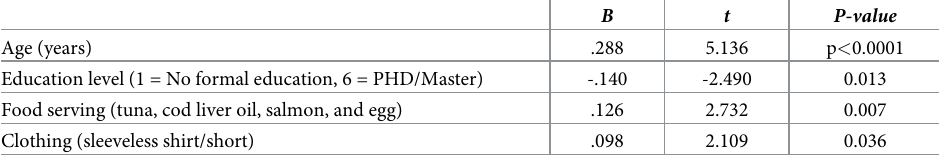
Bone pain as a symptom of hypovitaminosis was noted more frequently in female participants (126/242 vs. 48/150) with a significant P value of < 0.001. Muscle ache was statistically more common in females (112/242 vs. 57/150), but differences did not reach statistical significance. Similarly, back pain was found more often in females (110/242 vs. 59/150); however, these dif- ferences did not reach statistical significance. Fatigue was found more frequently in female participants (105/241 vs. 48/150), but this did not reach statistical significance. There was no Table 2. Linear regression for association of vitamin D levels with age, education level, food serving, and clothing habit. B